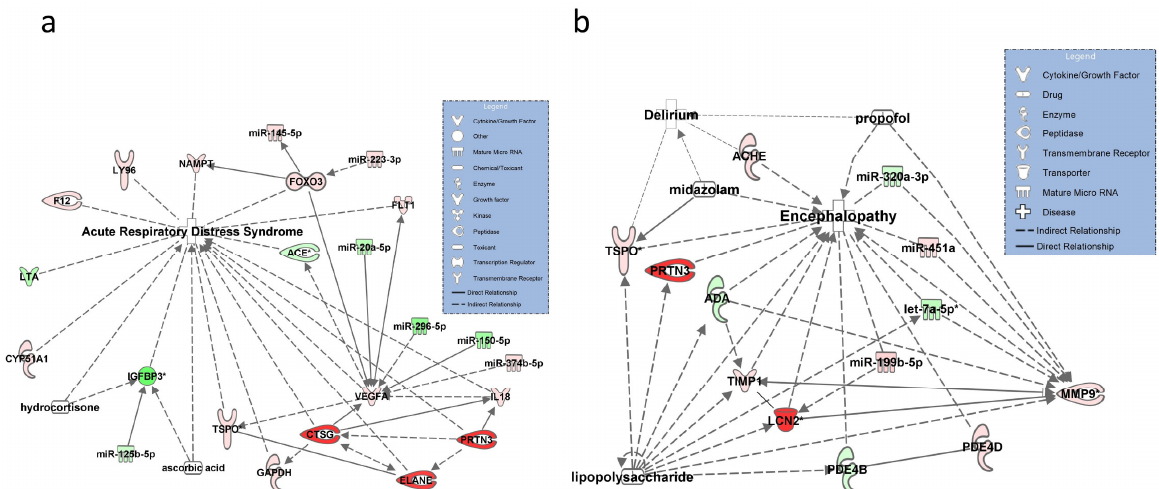
Figure 2. Molecular networks representing the SOFA symptom criteria 1 (“hypoxia”, left) and 2 “impaired Glasgow Coma Scale” (GCS, right). ( a ) The SOFA symptom criteria 1 was operationalized by the disease state acute respiratory distress syn-drome (ARDS) resulting in hypoxia. The network shows miRNAs and mRNA targets potentially involved in ARDS identified from the RNAseq and the RT-qPCR dataset. Hydrocortisone and ascorbic acid were included in the model targeting IGFB3 (insulin-like growth factor-binding protein 3). IGFB3, ACE (angiotensin-converting enzyme), and TSPO (mitochondrial permeability transition pore, also functioning a peripheral benzodiazepine receptor) were validated by RT-qPCR. ( b ) The molecular network for the SOFA symptom criteria 2 is visualized by the disease status septic enceph- alopathy and delirium. Let-7a-5p, miR-30c-5p, LNC2 (Lipocalin 2), MMP9 (matrix metallopeptidase 9), and TSPO were RT-qPCR validated in this network. Target transcripts of lipopolysaccharide and the sedatives propofol and midazolam, frequently used in patients with sepsis and resulting in lower GCS scores, are illustrated by arrows. Successfully validated molecules are marked with an asterisk in both networks. Solid lines connecting molecules in the networks indicate direct regulatory interactions and dashed lines indirect relationships between molecules and disease states. Downregulated and upregulated miRNAs and mRNAs are shown in green and red in both figures,